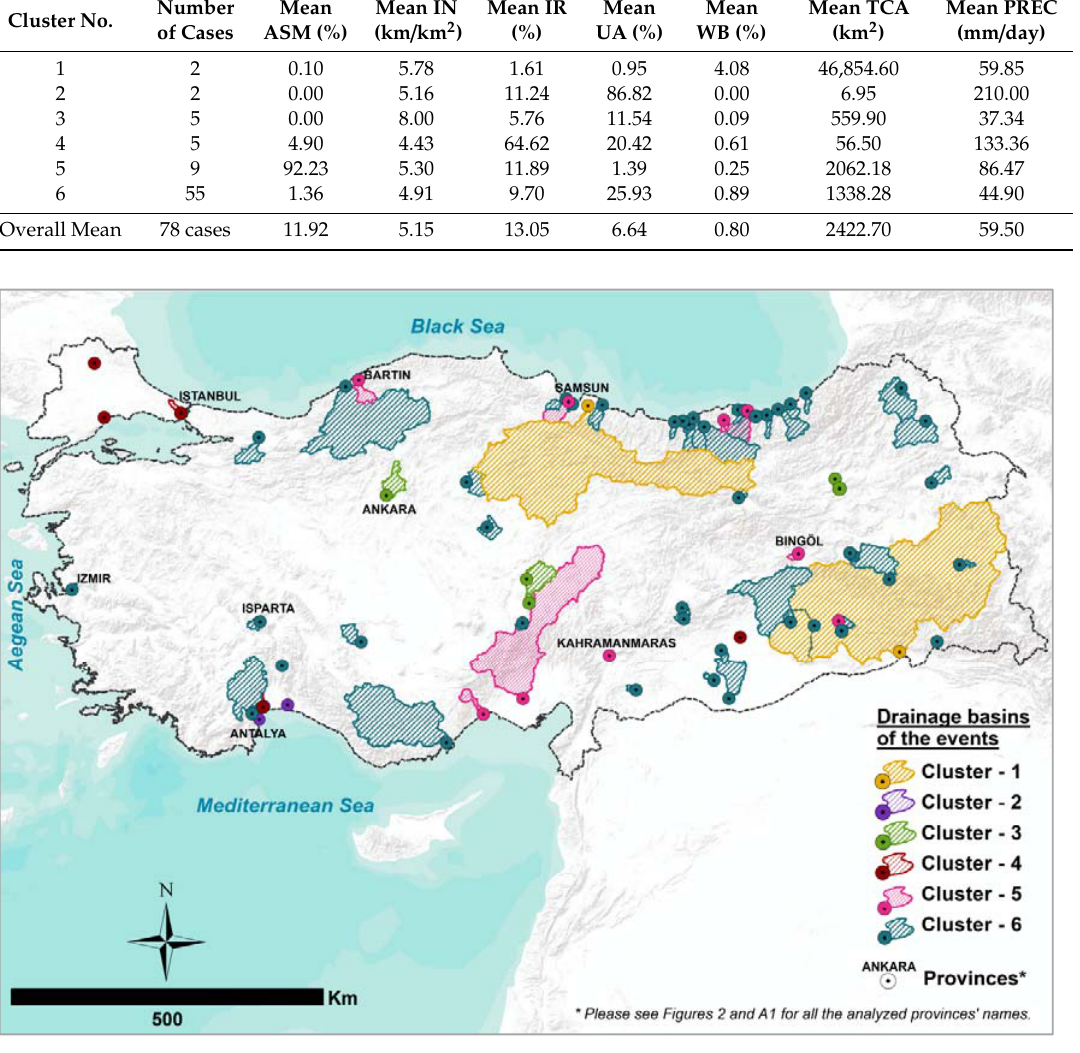
Figure 9. Spatial distribution of clusters.